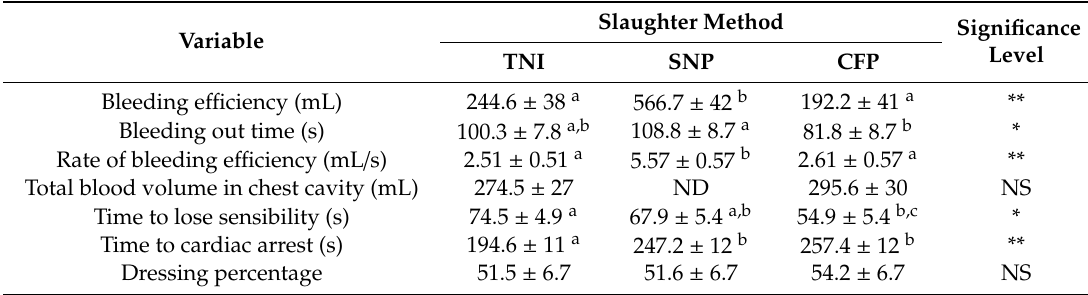
Values in the same row with di ff erent superscripts are significantly di ff erent at p < 0.05; * p < 0.05; ** p < 0.01; NS— p > 0.05.The bleeding e ffi ciency was lower ( p < 0.05) for goats slaughtered using the TNI (244.6 ± 38) when compared with the SNP slaughter technique (566.7 ± 42). Bleeding e ffi ciency did not vary ( p > 0.05) between goats slaughtered using the TNI when compared with the CFP slaughter technique. There was a negative correlation